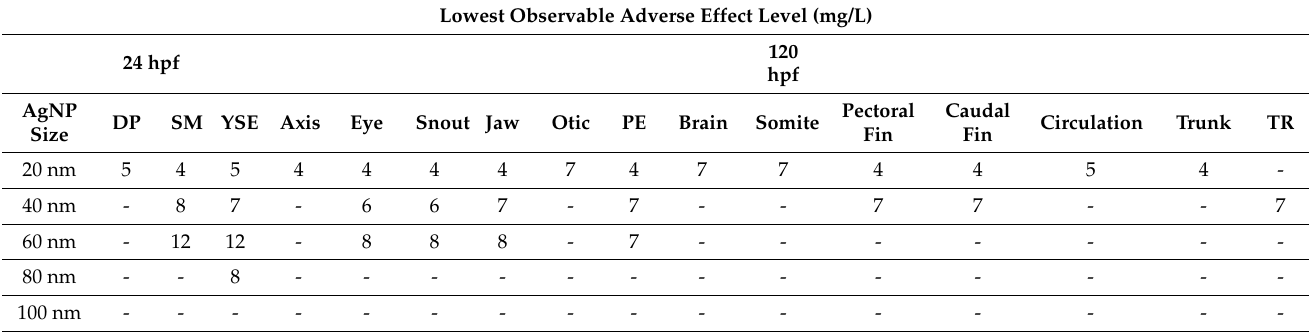
Table 1. Sublethal of hybrid lipid-coated AgNPs using an embryonic zebrafish